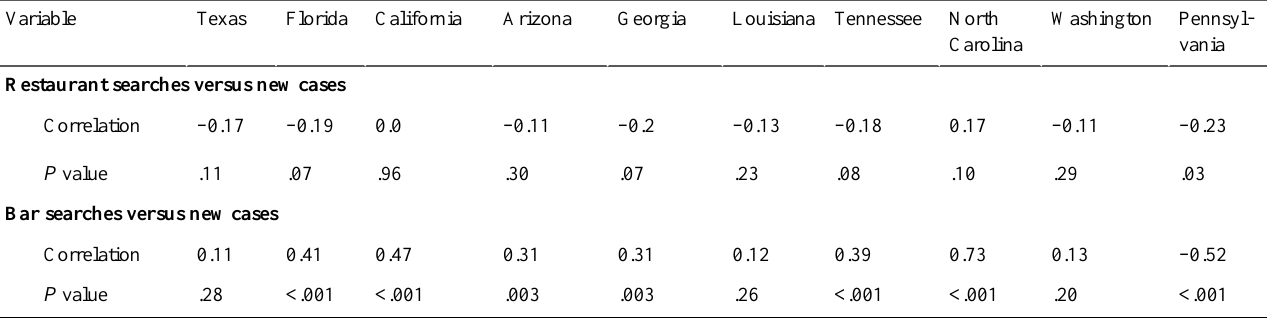
Table 3. Pearson correlations between search trends and daily new cases of COVID-19 for the 10 US states and territories with the most daily new cases from April 9 to July 7, 2020.